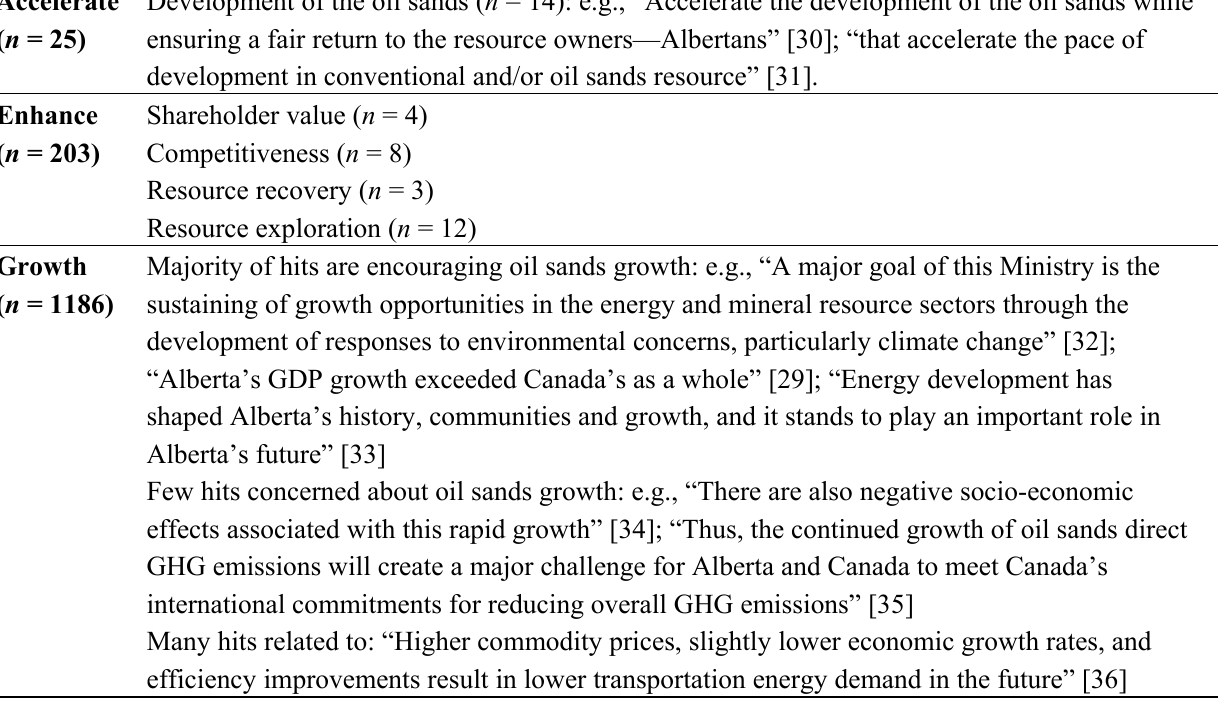
Table 2. Keywords supporting oil and gas production in the government reports. GDP: gross domestic